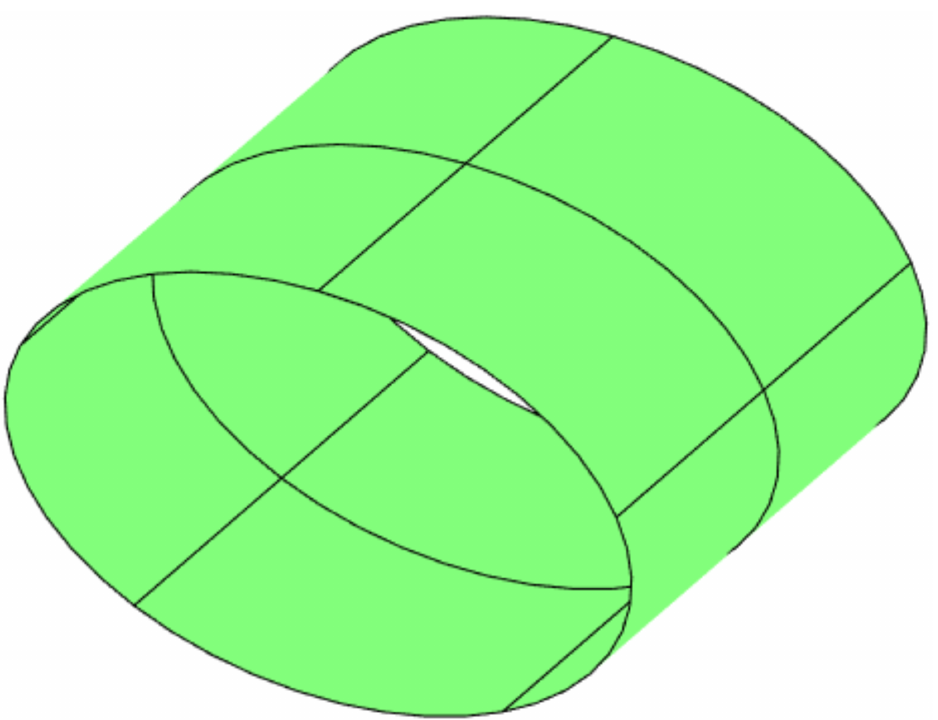
Figure 10. Cylindrical elliptical shell: